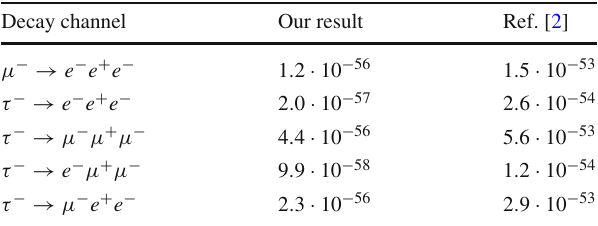
Table 2 Box contributions taking into account the constants in the Thompson limit Decay